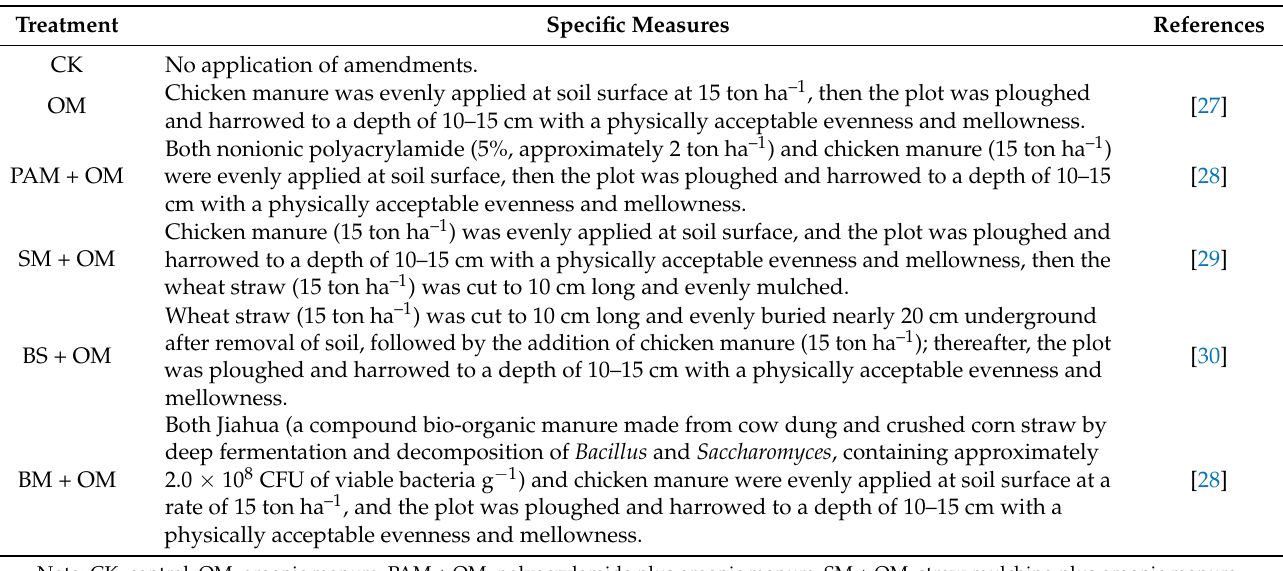
Table 2. Experimental treatment design and specific measures.